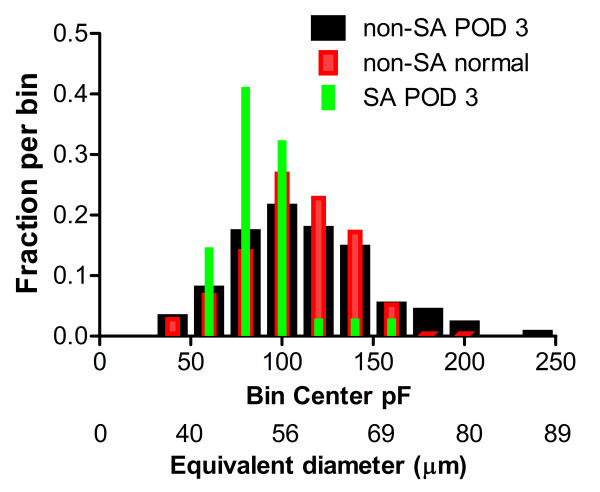
Distribution of membrane capacitance in spontaneously active vs. not spontaneously active cells (from experiments without green fiber visualization). There were not enough SA cells from normal DRG (n = 4) to include in the analysis. Equivalent diameters are based on a sphere with membrane capacitance of 1 μF/cm2